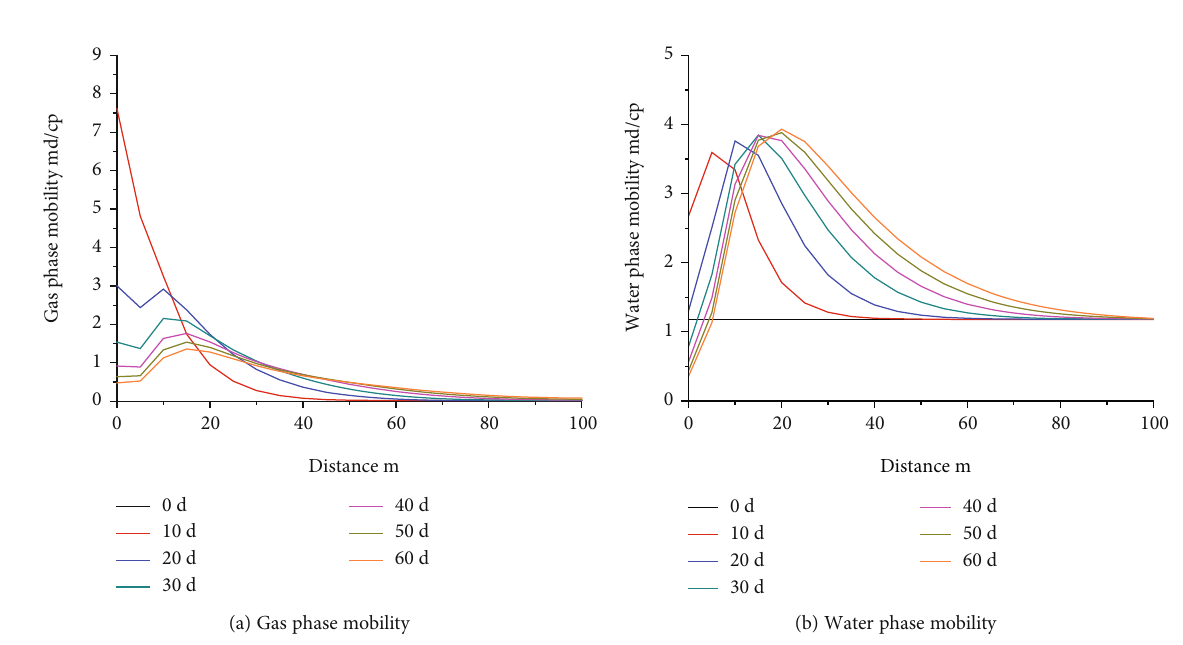
Figure 8: Variation of the fl uid mobility under di ff erent